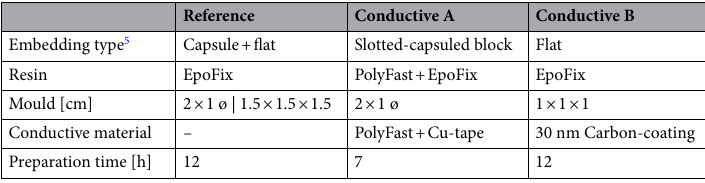
Table 2. Overview of the preparation methods.